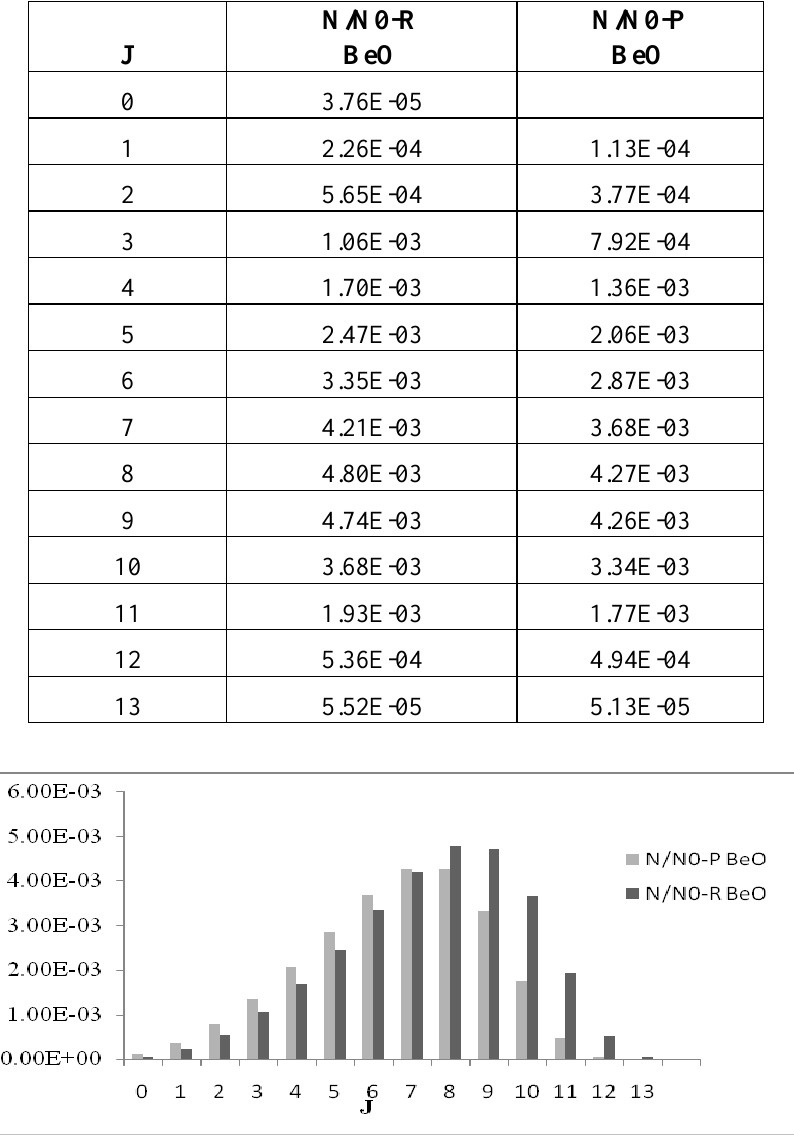
Fig. 1: Relative population of B 1 Σ + -X 1 Σ + as a function of J for BeO molecule